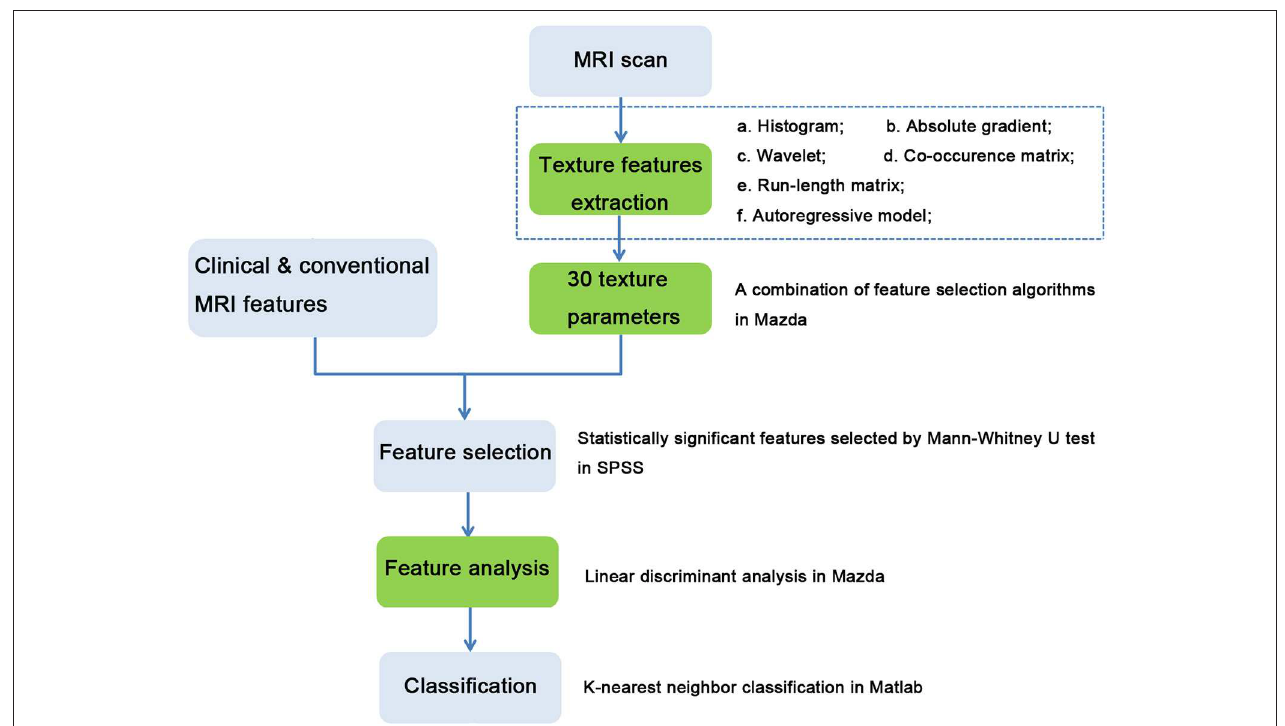
FIGURE 2 | Workflow chart of distinction between phyllodes tumors and fibroadenomas based on clinical and conventional MRI features, and texture features. Processes in green boxes were performed in